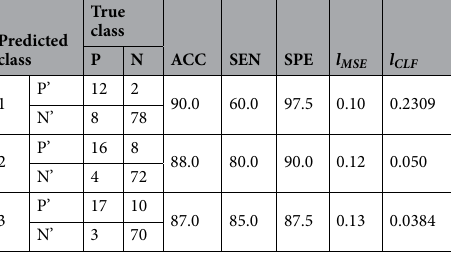
Table 2. Confusion matrices and loss values of three examples, in terms of SEN and SPE, the best is Example 3 and the worst is Example 1.